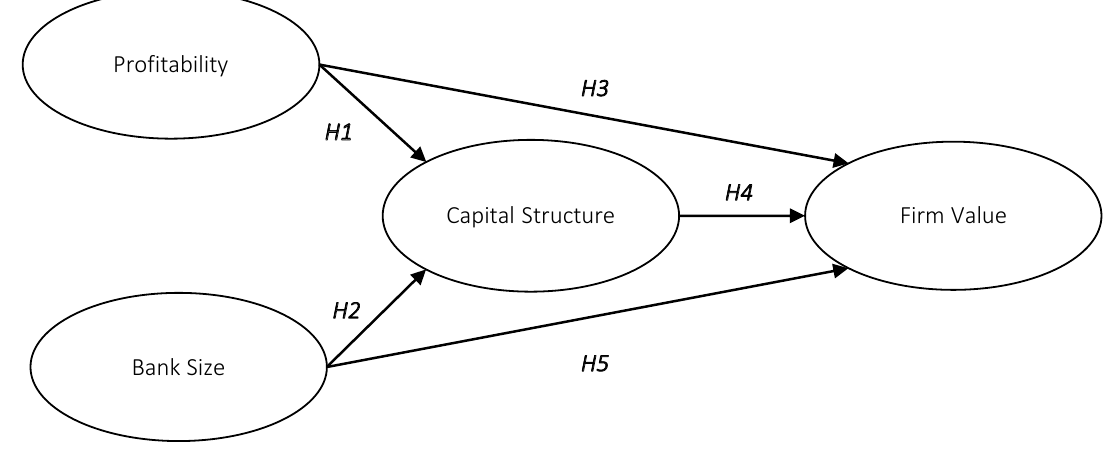
Figure 1. Research model